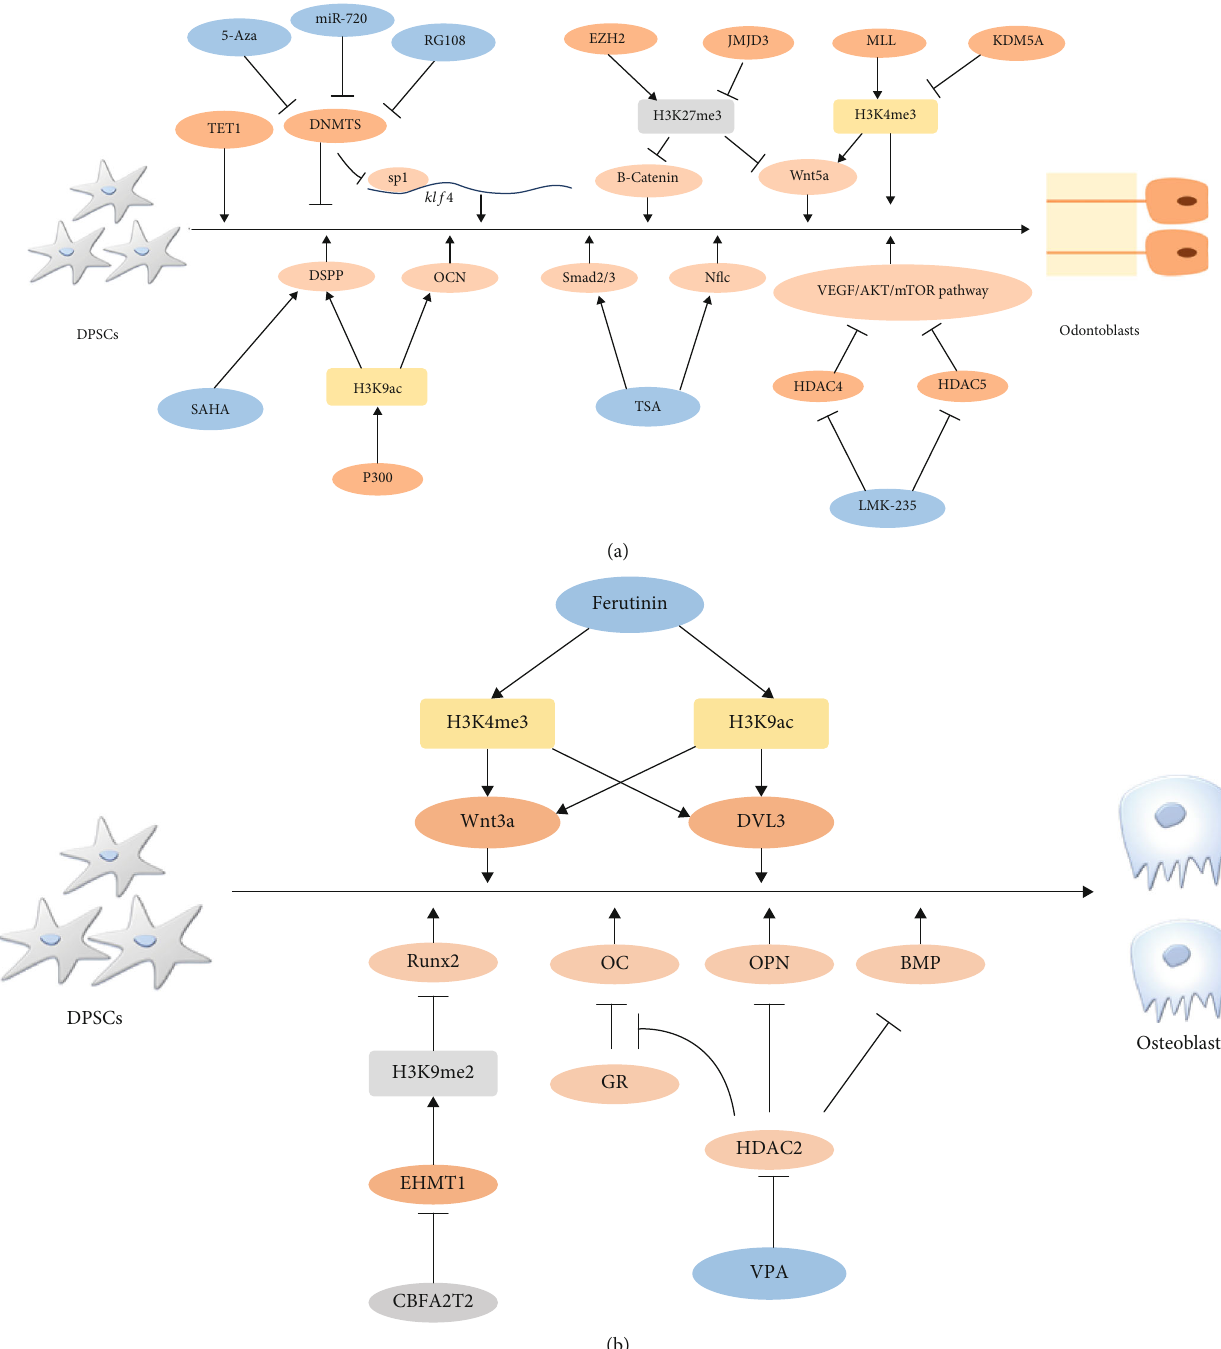
Figure 2: The modulation of DNA methylation and histone modi fi cations during the odontogenic and osteogenic di ff erentiation in